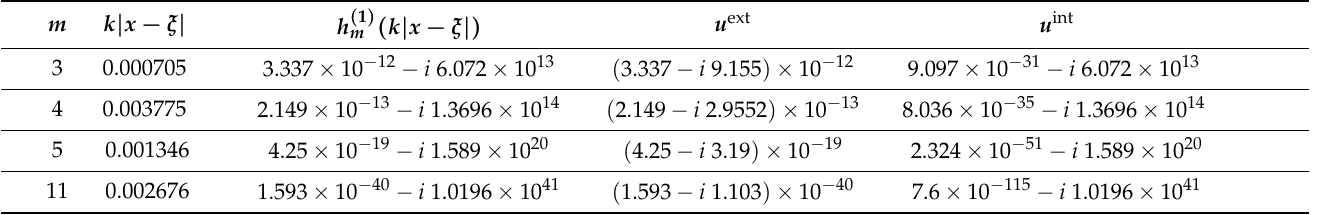
Table 2. Validation of the Representation (55) in the case of radiating fields emanating from ξ . In all cases, k η = π × 10 − 6 , while e m take the prescribed values presented in Table